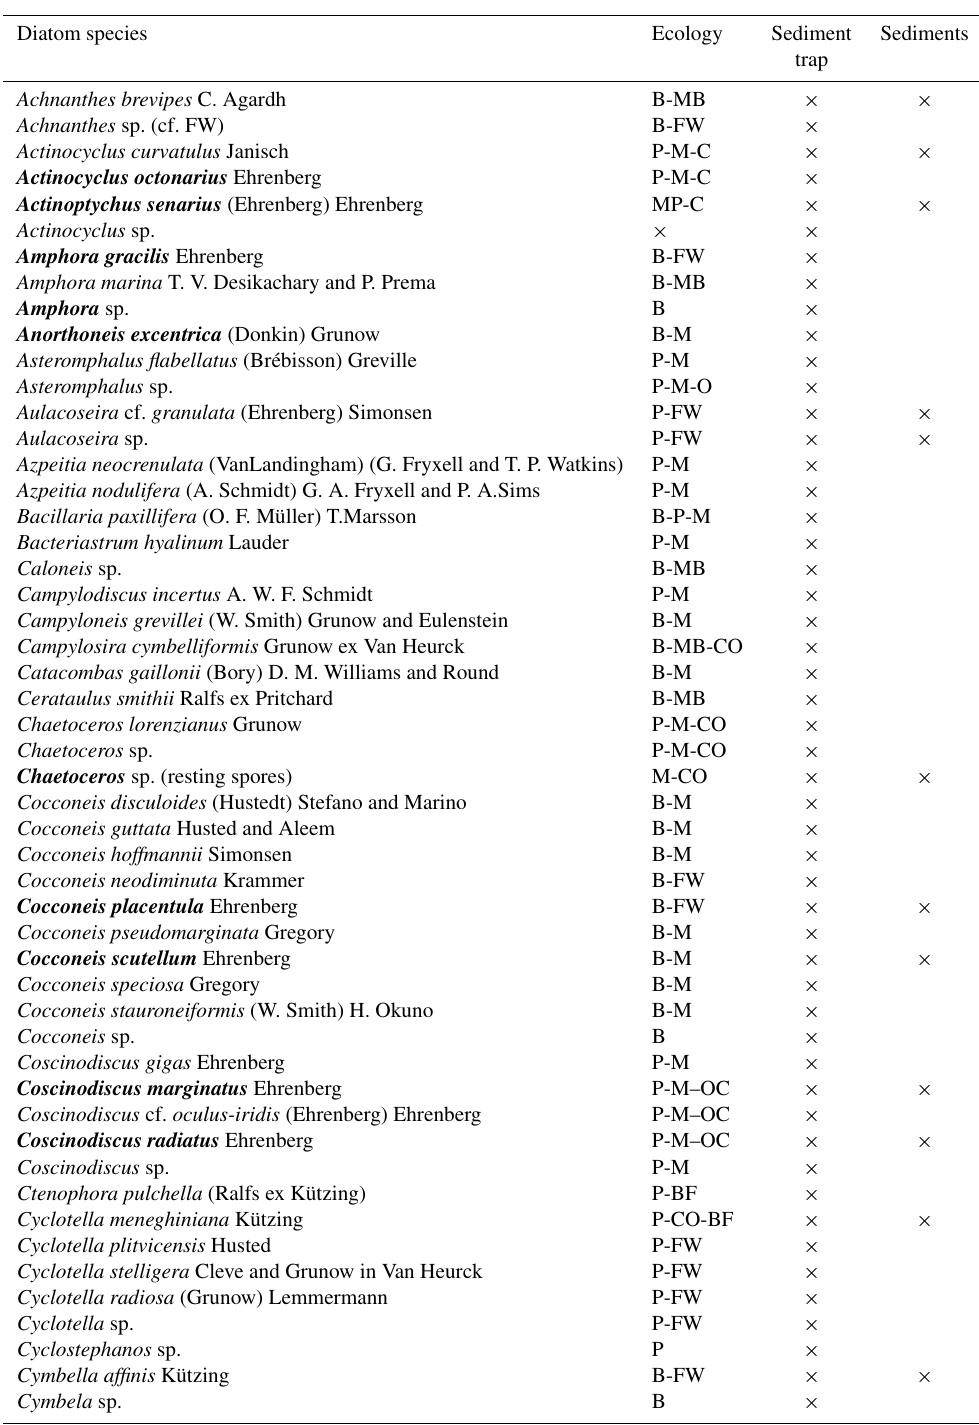
Table A1. List of diatom species found in both the RAIA sediment trap and surficial sediment sample (Geo B 11002). Species that appeared in more than one sediment trap sample with a percentage higher than 2% of the total abundance are highlighted in bold. Ecology preferences: B is benthic; MP is meroplanktonic; P is planktonic; CO is coastal; O is open ocean; C is cosmopolitan; M is marine; MB is marine to brackish; BF is brackish to freshwater; BR is brackish; FW is